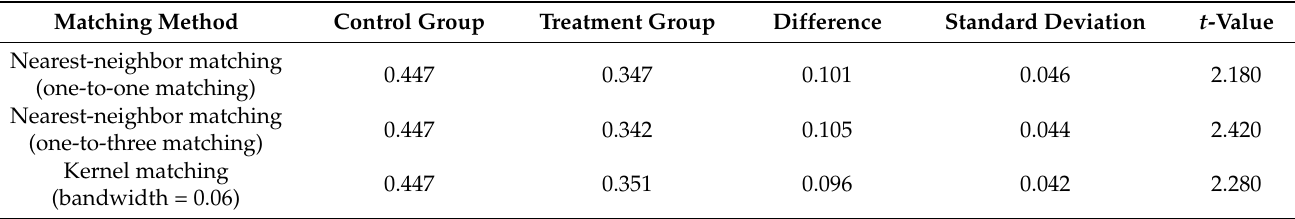
Table A3. The results of average treatment